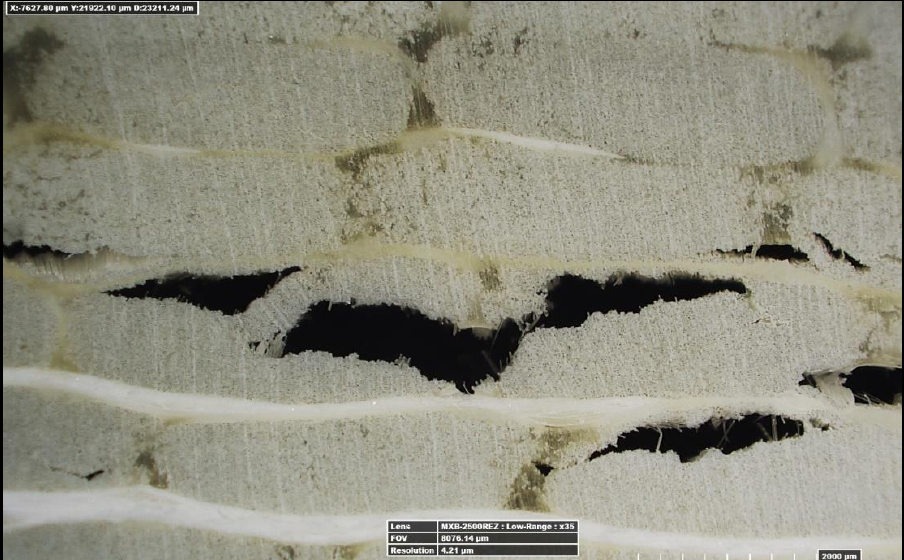
Figure 4. R-glass FRP plate with a ( bottom ; ×35 magnification) transverse and ( top ; ×140 magnification) hoop fiber orientation after a week of exposure to pH 1.7 aqueous solution.